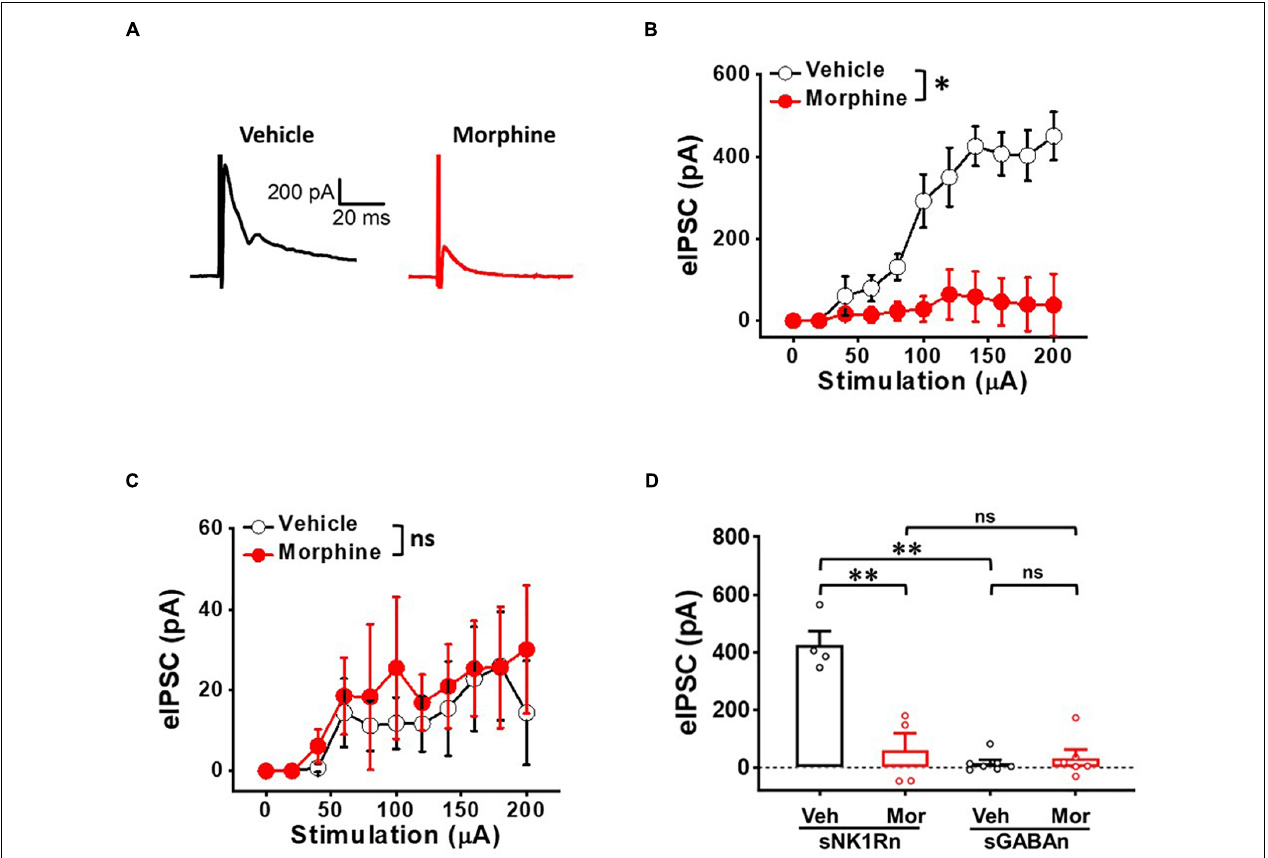
FIGURE 7 | Repeated morphine treatment decreases inhibitory synaptic strength in sNK1Rn. (A) Representative traces of evoked inhibitory postsynaptic current (eIPSC) from sNK1Rn. Stimulus-response curve of eIPSC from panel (B) sNK1Rn (Vehicle: N = 4, n = 9; Morphine: N = 4, n = 19) and (C) sGABAn (Vehicle: N = 7, n = 48; Morphine: N = 6, n = 26). ns: not significant, ∗ p < 0.05 vs. vehicle by Sidak’s multiple comparison test following multilevel analysis. (D) eIPSC (at 140 µ A) of sNK1Rn and sGABAn from panels (B,C) , respectively. Effect size: –3.34, p = 0.0037 for sNK1Rn: Vehicle vs. Morphine. Effect size: 0.37, p = 0.5718 for sGABAn: Vehicle vs. Morphine. Effect size: –6.73, p = 0.002 between Veh:sNK1Rn and Veh:sGABAn. Effect size: –0.27, p = 0.734 between Mor:sNK1Rn and Mor:sGABAn. ∗∗ p < 0.01; Welch’s t